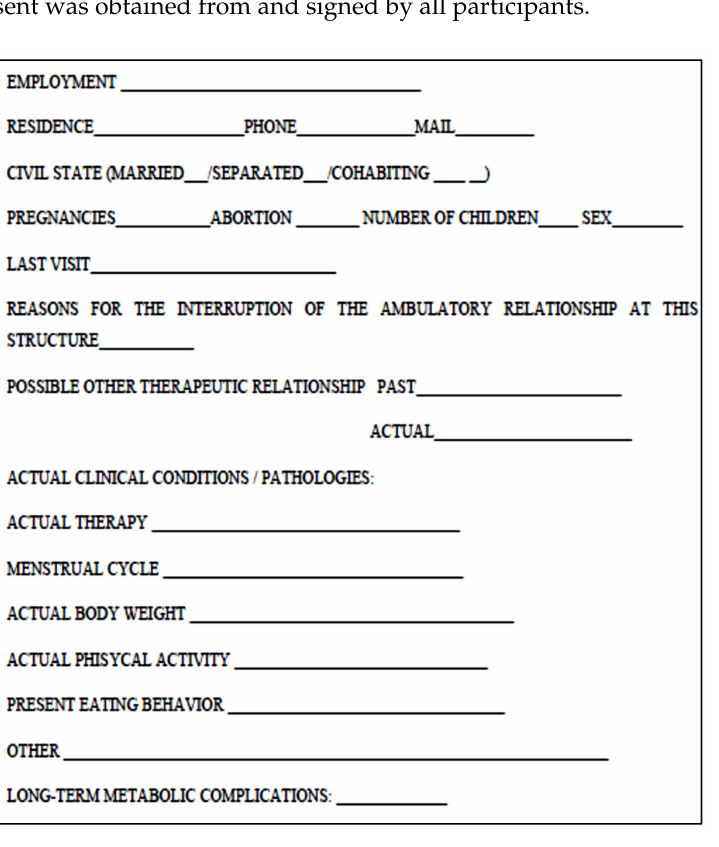
Figure 1. General data collection